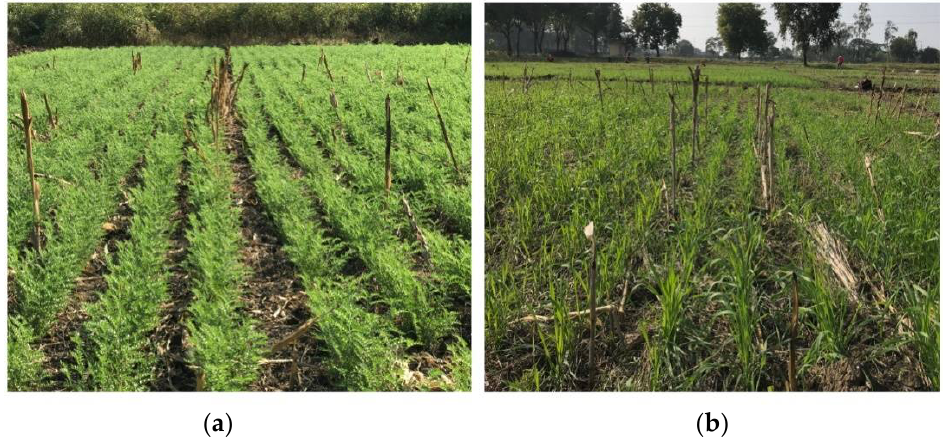
Figure 2. Crop raised under conservation agriculture: ( a ) Chickpea ( Cicer arietinum ) ( left ), ( b ) wheat ( Triticum aestivum ) ( right ).